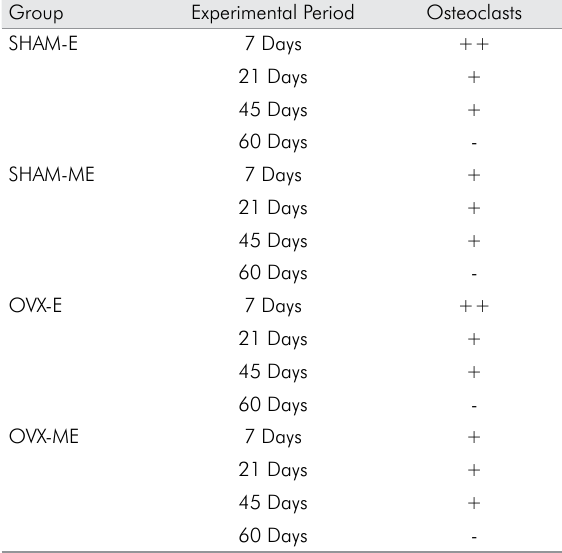
Table 1. Summary of RANK